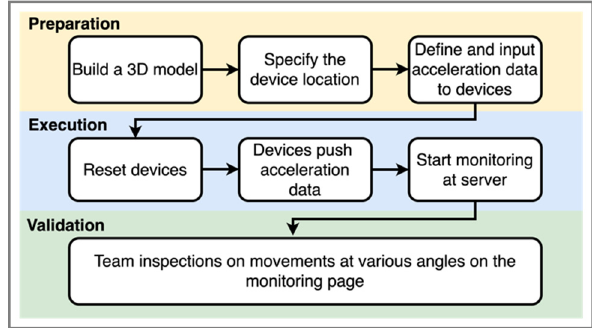
Figure 15. Global to local conversion validation procedure.